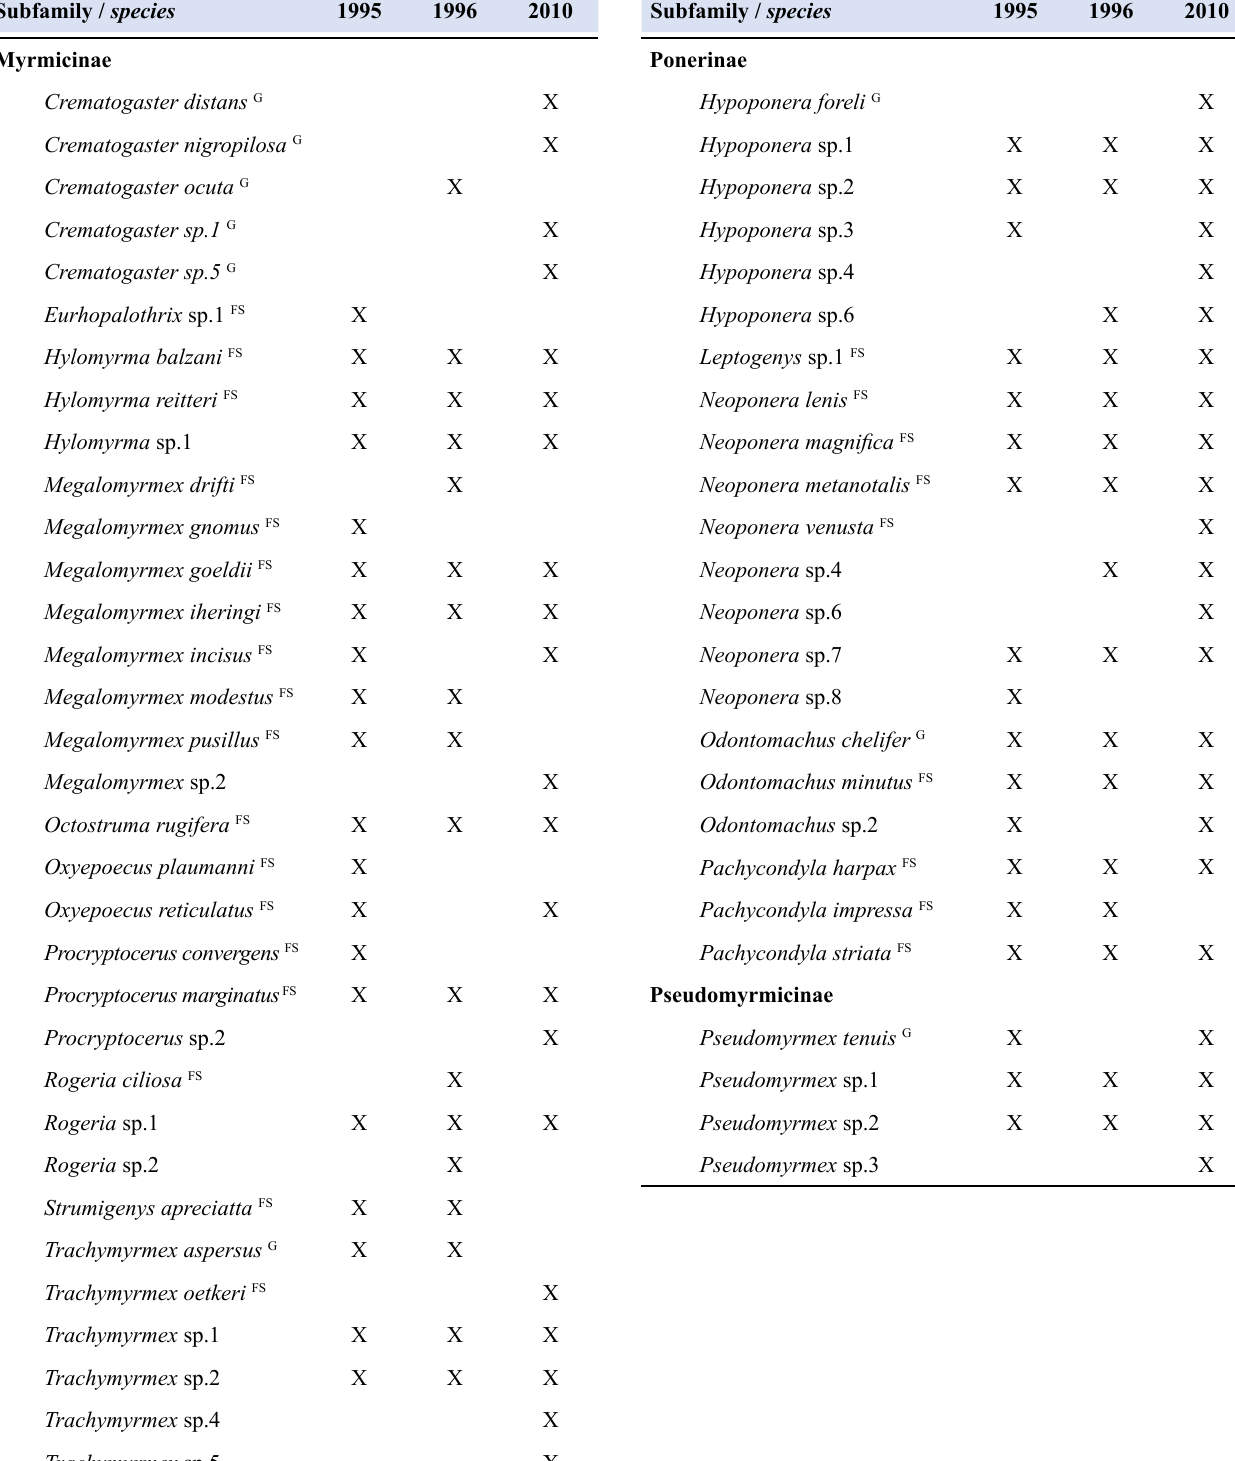
Table S3. Ant species sampled in the years of 1995, 1996 and 2010. The letter G represents the species classified as generalists, letters FS as forest specialist and letters OH those species classified as open-habitat specialist. (Continuation) Subfamily /